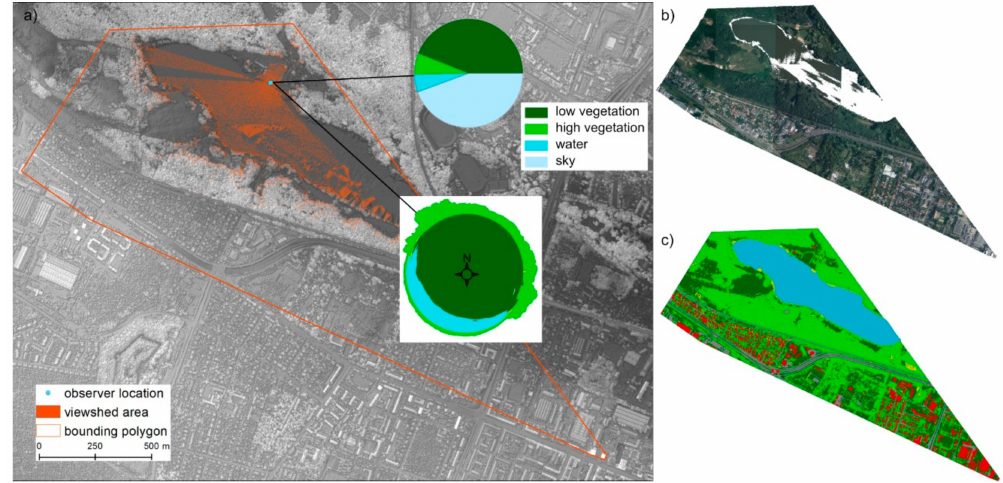
Figure 9. Observer location, viewshed analysis, and landscape analysis results ( a ), RGB LiDAR point cloud ( b ), CDSM ( c